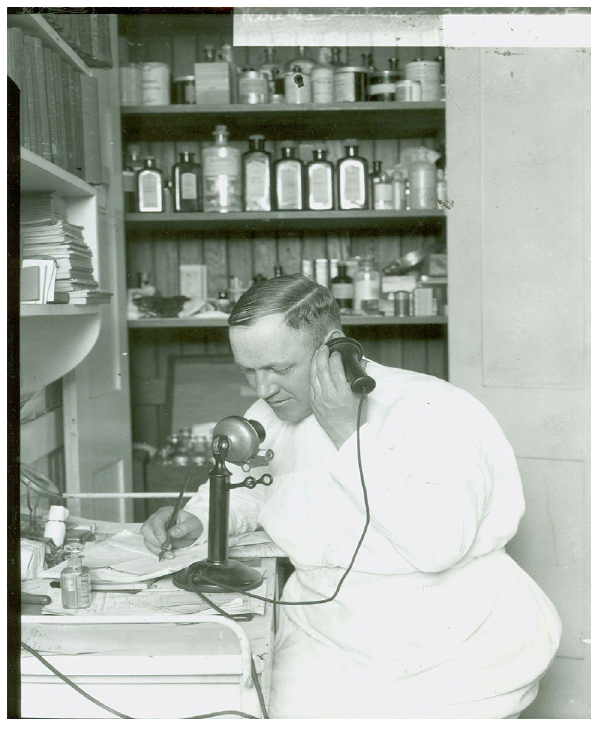
Figure 3 Medical information is relayed via SCI’s